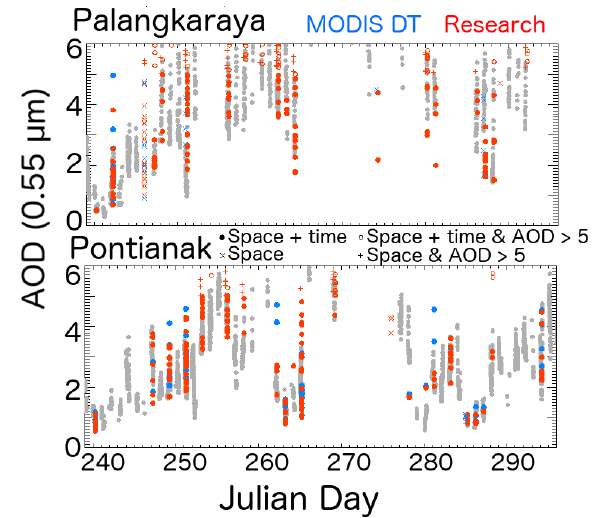
Figure 8. Time series of all AERONET observations of AOD at 0.55µm (in grey) as a function of Julian Day in 2015, and the cor- responding MODIS DT (in blue) and research (in red) AOD over the Palangkaraya and Pontianak AERONET sites. MODIS data that are temporally and spatially collocated with AERONET are shown by dots, data with values greater than 5 are shown by open circles. Same-day spatial collocations that are not restricted to ± 30min of overpass are shown by crosses and data with values greater than 5 are shown by plus sign. All individual MODIS retrievals within 0.3 ◦ of the AERONET site are included on the plot without